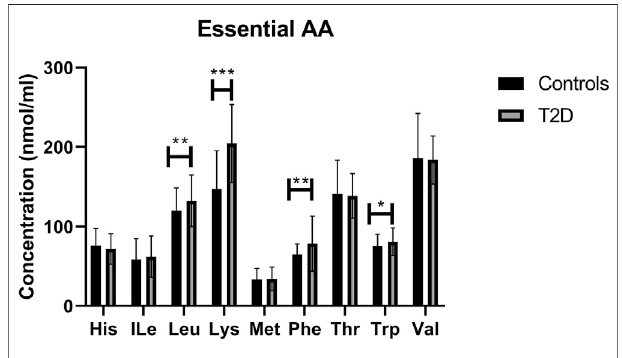
FIGURE 2 | Plasma concentration of essential amino acids in type 2 diabetes (T2D). Statistically signi fi cant increase in Leu, Lys, Phe, and Trp was